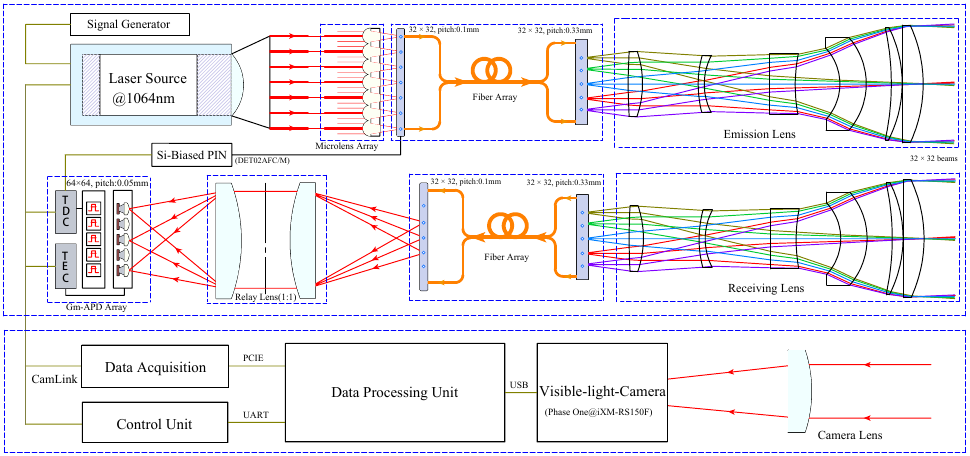
Figure 1. Schematic of 3D imaging LiDAR. The system comprises a transmitter, receiver, and visible camera. Fiber optics are used in the transmitter and receiver to achieve 32-by-32 laser beams for transmitting and